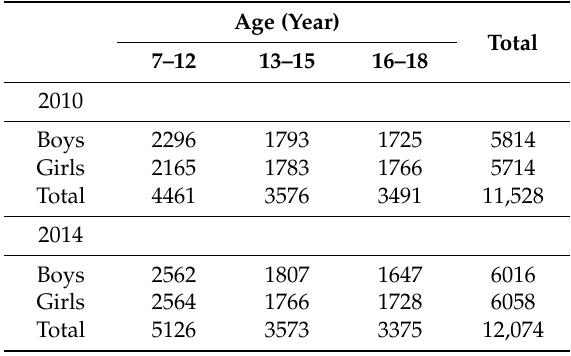
Table 1. Characteristics of study population in 2010 and 2014.